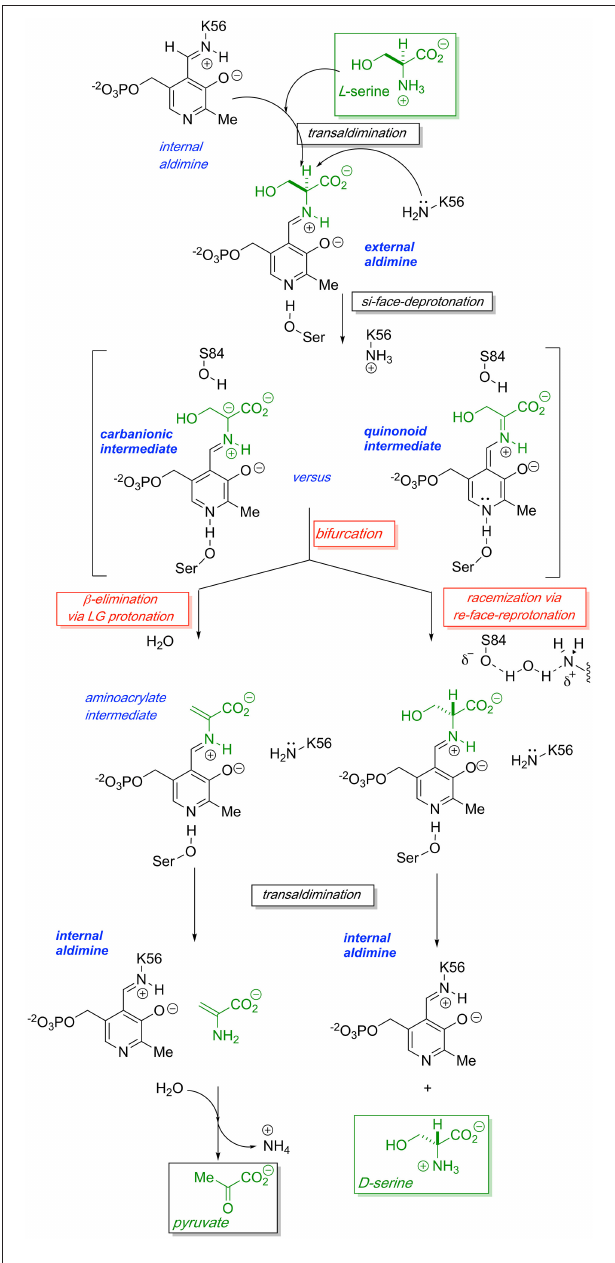
FIGURE 2 | Proposed bifurcating mechanism of hSR showing the racemization reaction vs. the competing β -elimination reaction via a common carbanionic or quinonoid